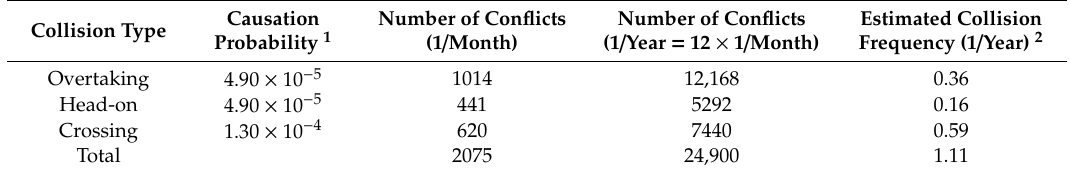
Table 4. Ship collision accident estimation in the Singapore